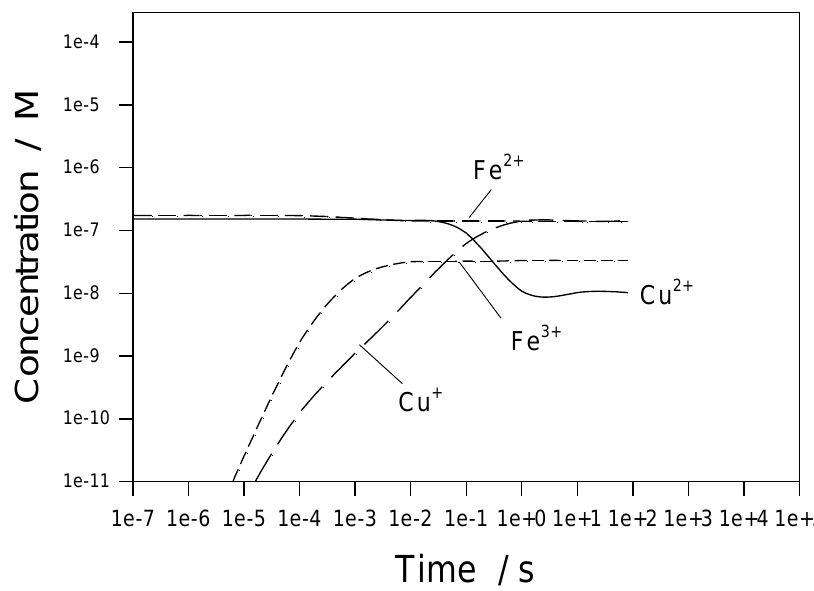
Figure 34. Predicted concentrations of metal species in an average equatorial module as a function of time. Initial conditions are [Cu 2+ ] = 10 ppb, [Fe 2+ ] = 10 ppb, and [Cu + ] = [Fe 3+ ] = 0. [H 2 ] Inlet = 1 cc(STP)/kg H 2 O.